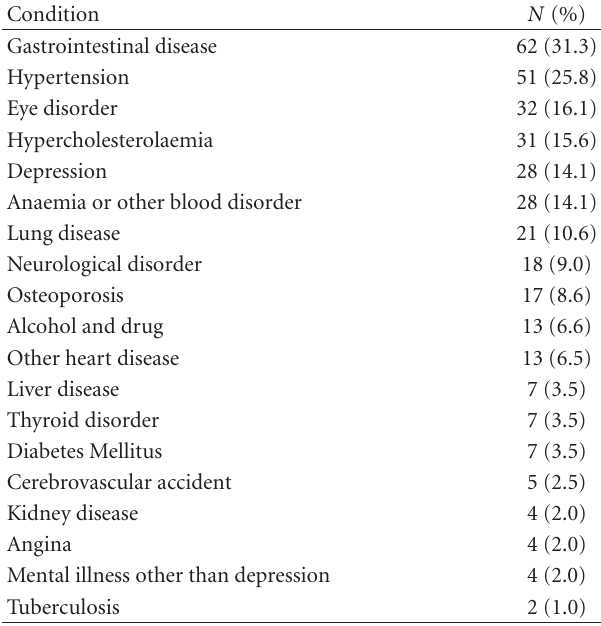
Table 2: Self-reported comorbid conditions among ankylosing spondylitis patients commencing biological therapy ( n =